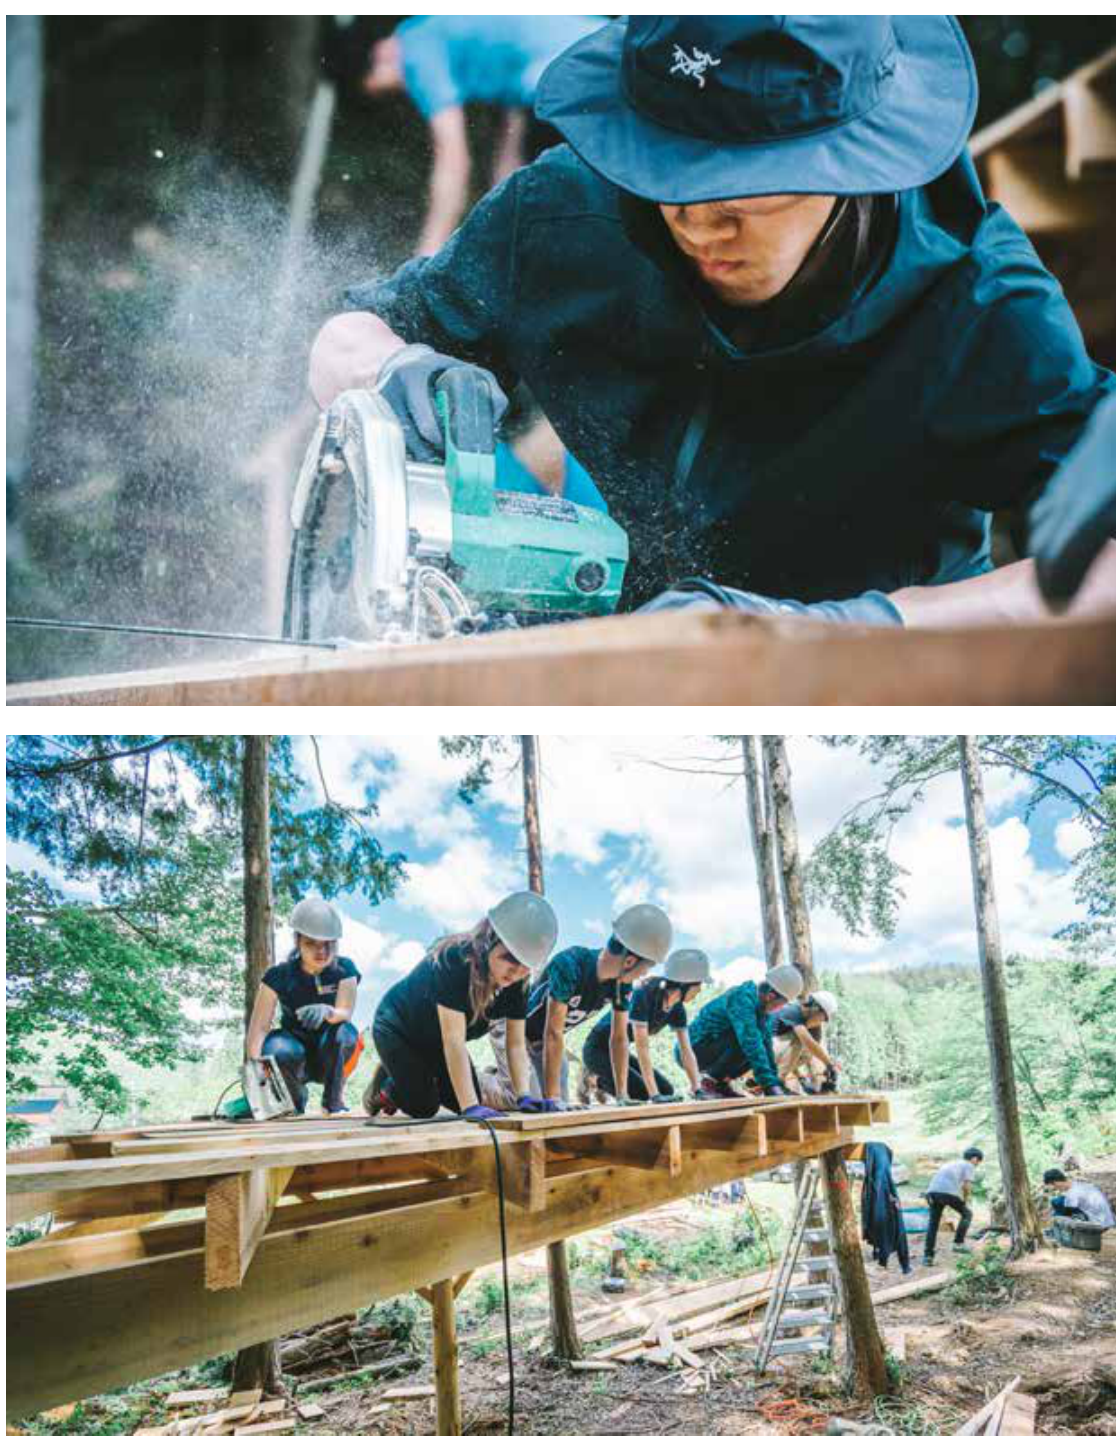
Figure 7 (previous page): WHARF Liming Village Wu Zhi Qiao (2018): Bailey bridge design and build in Liming Village, Lijiang, Yunna, China. Source: